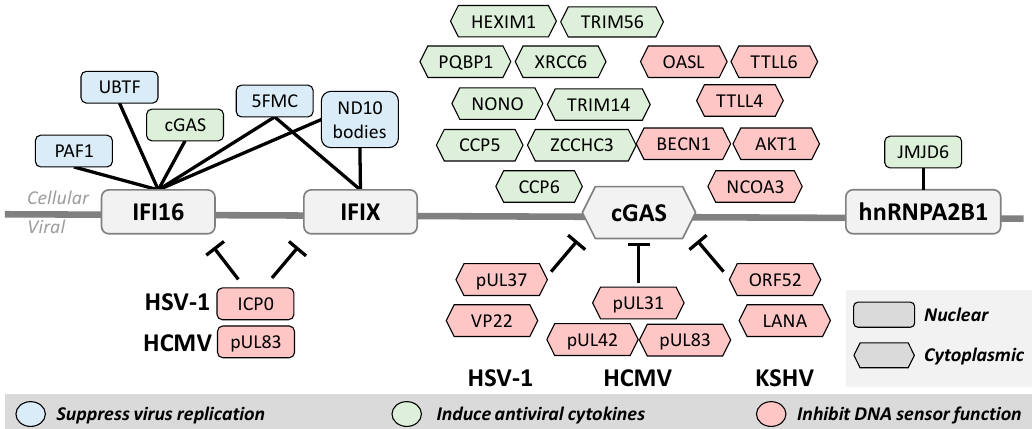
Figure 3. Protein–protein interactions contribute to the activation or inhibition of DNA sensor. Over the course of viral infection and immune signaling, DNA sensors interact with other cellular and viral proteins. Several of these cellular proteins are important for the function of the DNA sensors for both suppressing virus replication by repressing viral transcription and inducing antiviral cytokines. Protein interactions are also used to regulate DNA sensor function. Viruses have evolved distinct mechanisms to facilitate immune evasion and cells must also possess mechanisms to prevent excessive immune signaling. Although localized to both the nucleus and cytoplasm, protein interactions with cGAS are best characterized in the cytoplasm. Nuclear proteins are shown here as rectangles and cytoplasmic interactions as hexagons.